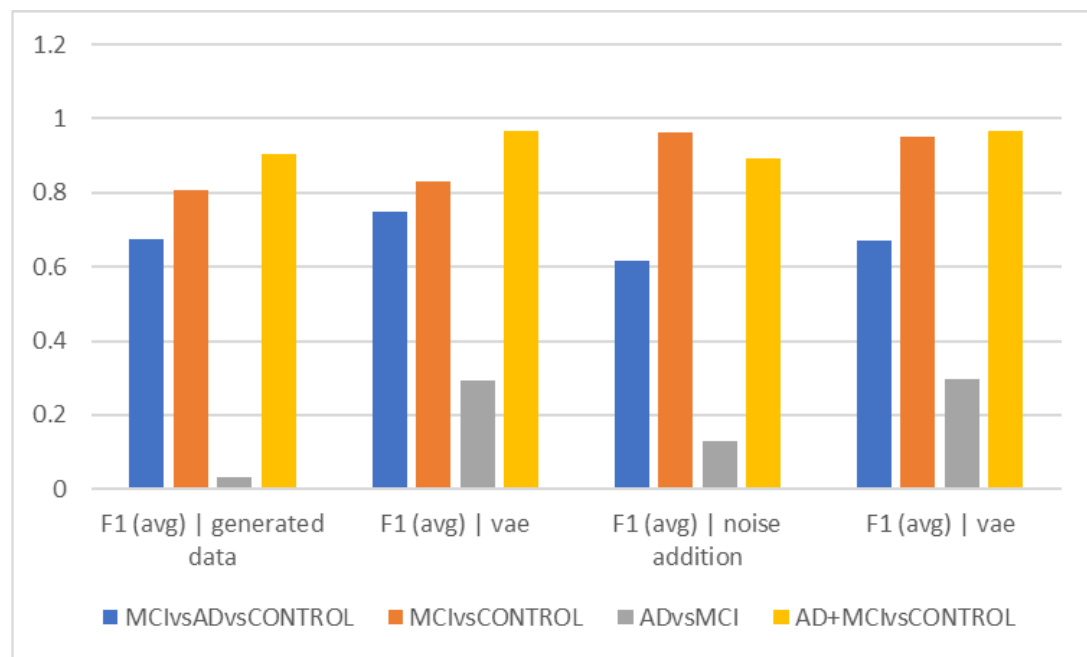
Figure 3. Comparison of results for 5 s (F1).